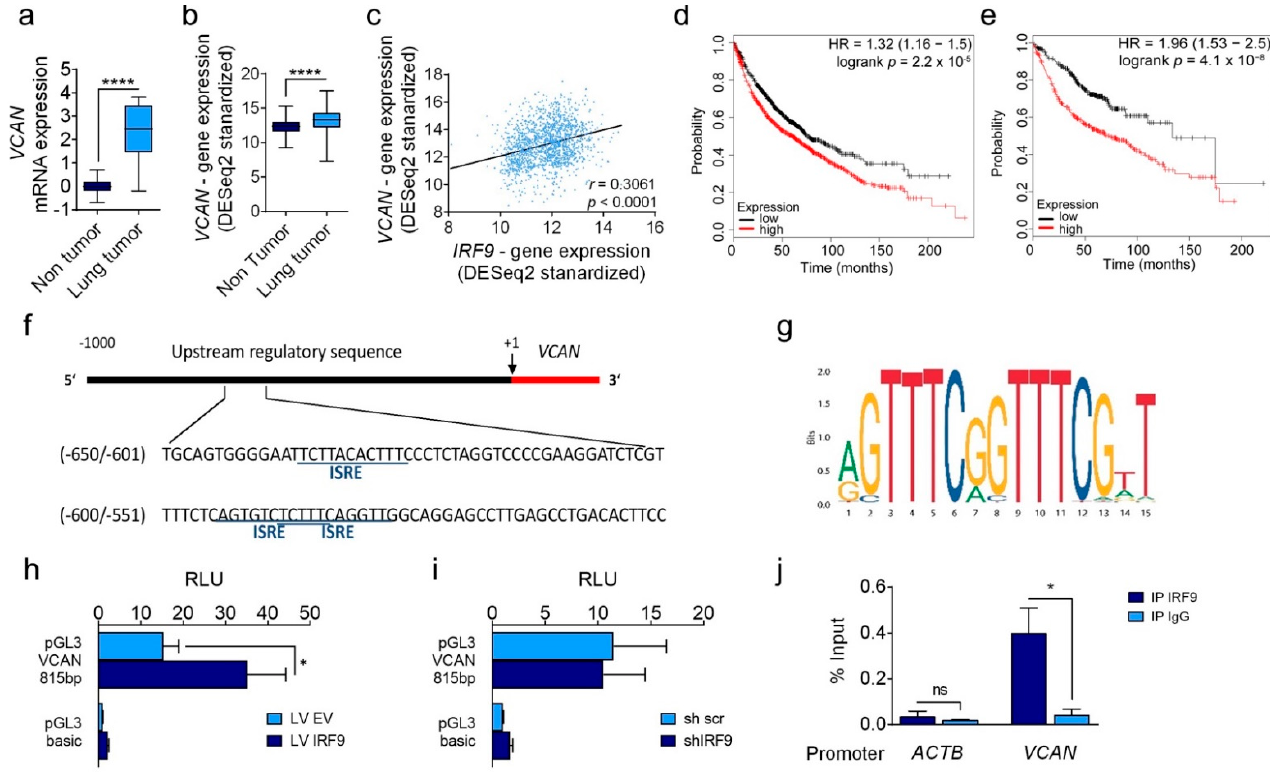
Figure 5. VCAN expression is regulated by IRF9 and is associated with lower overall survival in patients with lung cancer. ( a ) mRNA expression of VCAN in LUAD and non-tumor tissues ( n = 11). ( b ) VCAN gene expression of lung tissues ( n = 287) and patients with LUAD ( n = 573) from the TCGA TARGET GTEx study. ( c ) Scatter plot of IRF9 expression correlated with VCAN expression in lung tumor samples from a TCGA dataset ( n = 1122). The R value and two-tailed p value were calculated using Pearson’s rank correlation coefficient. ( d , e ) Kaplan–Meier curves of VCAN expression in all classes of patients with lung cancer ( d ; n = 1926) and LUAD ( e ; n = 720). Kaplan–Meier curves show the median divided into high and low expression. ( f ) Sequence of the VCAN promoter and potential ISRE based on a FIMO search are underlined. ( g ) IRF9 binding motif from open-access database JASPAR (matrix ID MA0653.1). ( h , i ) Transfection of pGL3 VCAN 818 bp showed higher luciferase activity in relative light units RLU 1 = pGL3 control ( h ) A549 LV IRF9 was correlated with A549 LV EV, whereas no difference was noted between ( i ) A549 shIRF9 and A549 sh scr ( n = 3). ( j ) Chromatin-immunoprecipitation was performed using an antibody against IRF9 and the respective IgG in naïve A549 chromatin. Purified DNA was analyzed using RT- qPCR in the promoter of ACTB and VCAN ( n = 3). Data are expressed as means ± standard error of the mean. Analysis was performed using Student’s t -test or one-way analysis of variance with Welch’s t-test: * p < 0.05; **** p < 0.0001.